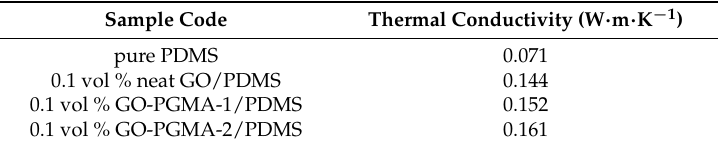
Table 2. Thermal conductivity of pure PDMS and PDMS composites with various fillers.